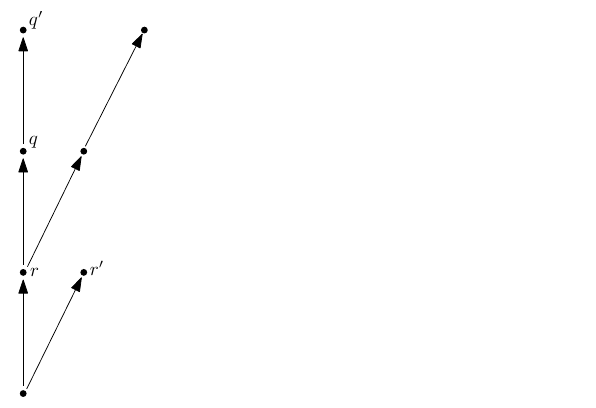
Figure 1. Suppose that s i − 1 = ♦ ( r ∧ ♦ ( q ∧ ♦ q (cid:48) )) ∧ ♦ r (cid:48) and s i = ♦ ( r ∧ ♦ ( q ∧ ♦ q (cid:48) ) ∧ ♦♦ (cid:62) ) ∧ ♦ r (cid:48) with M s , M s and g as in the figure. Then the term corresponding to the ‘part of M s i − 1 i above g ( y ) ’ is q ∧ ♦ q (cid:48) . Therefore, we substitute p : = q ∧ ♦ q (cid:48) in ♦ p → ♦ p ∧ ♦♦ (cid:62) and infer ♦ ( q